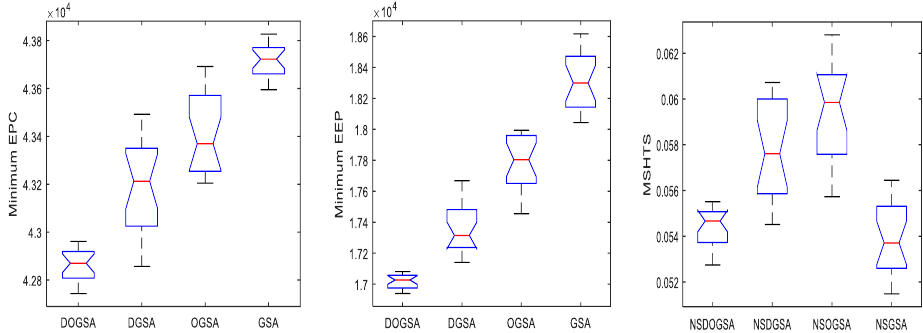
Figure 8. Box-type plots of Kruskal-Wallis test for Test system-II.